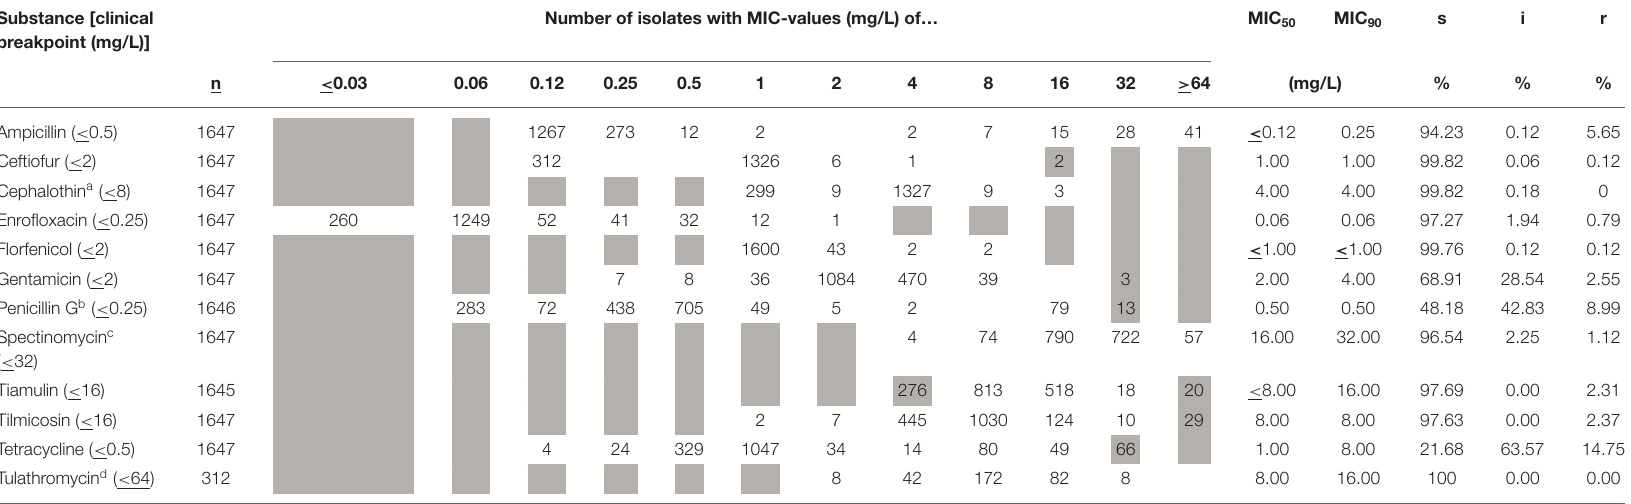
TABLE 3 | MIC distribution of APP isolates originating from the respiratory tract and the pleural cavity tested within the time period 2006–2020. Substance [clinical breakpoint